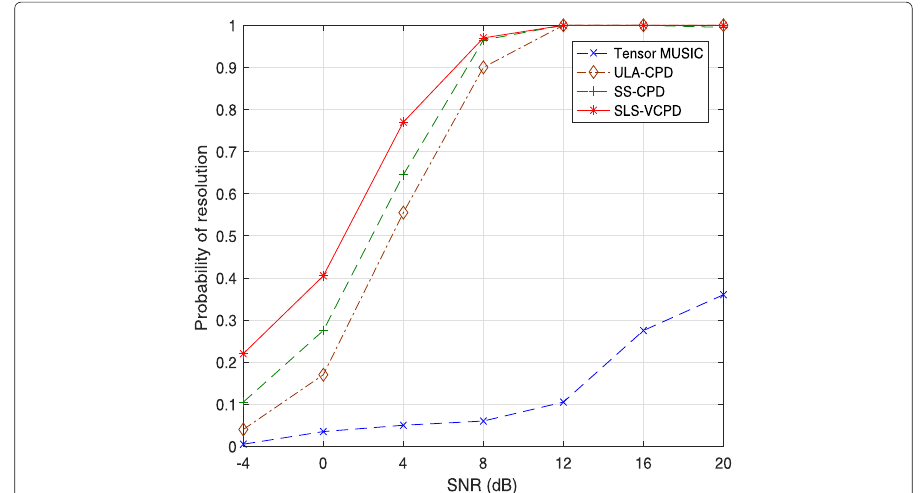
Fig. 10 Resolution ability versus SNR for two spatial closely located sources with M = 6, and the number of samples is set as T =